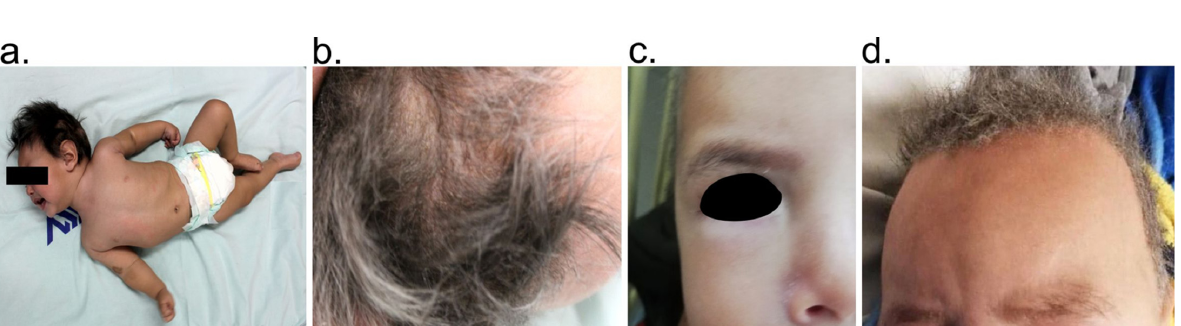
Figure 2. Physical features of the patient with Menkes disease. In addition to neurological alterations, features such as hypotonia ( a ), brittle hair together with alterations in the hair pigmentation ( b ) and ( d ), and hypopigmented skin areas in the face ( c ) were identified. In the second medical visitation, tanned skin ( d ) and “kinky” and “steely” scalp hair were more evident.